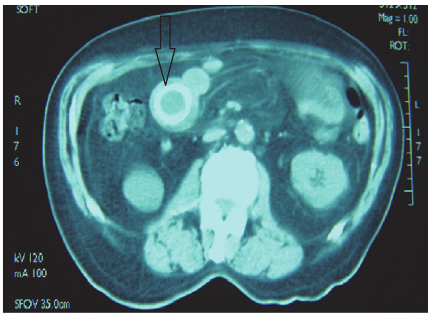
Figure 1: Contrast-enhanced computed tomographic image show- ing dilated jejunal loop (up to 5cm in diameter) with a large calcified ring (black arrow).